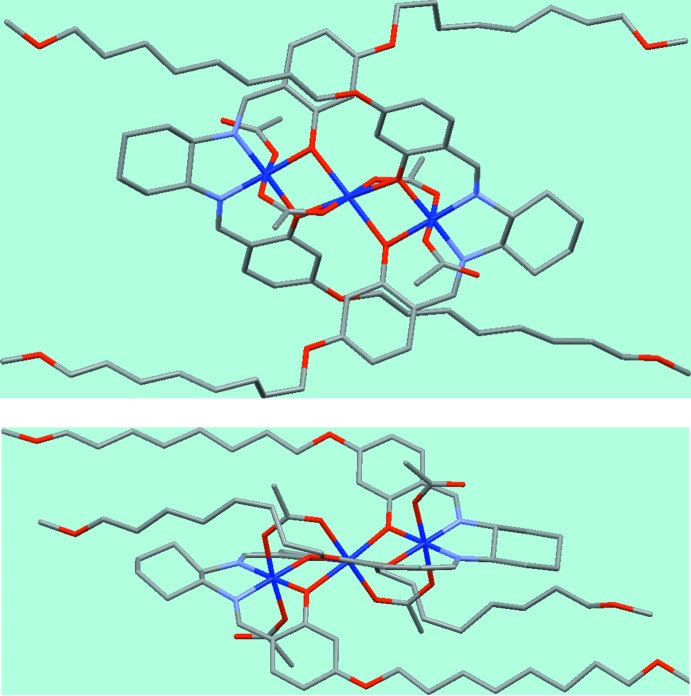
Two views (without H atoms) of the mol­ecule of the cobalt salen complex.